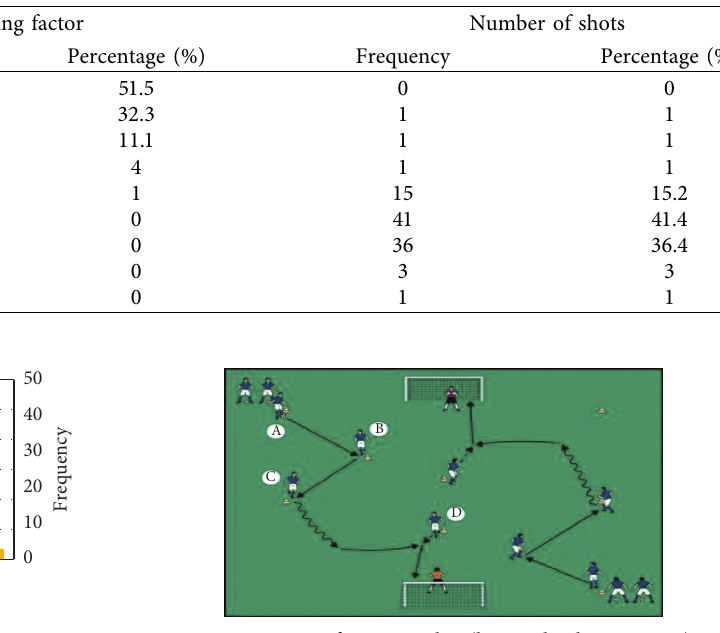
Figure 5: One-foot pass play